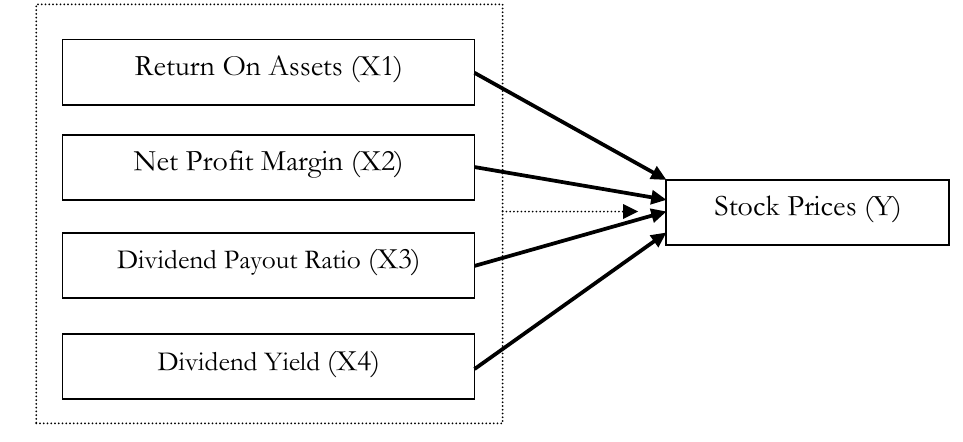
Figure 1. Research